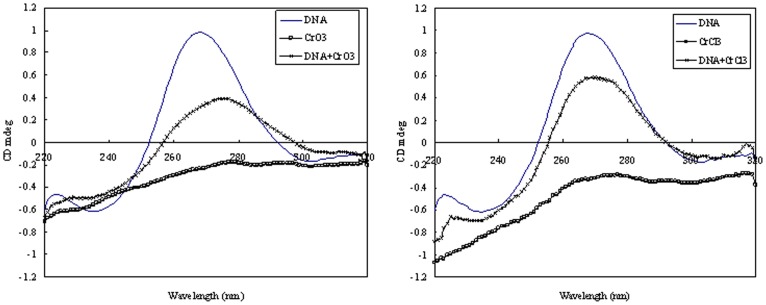
Effects of Cr(VI) and Cr(III) on the CD spectra of plasmid DNA.Plasmid DNA (25 ng/µL) was measured in the presence or absence of 150 µM CrO3 or CrCl3.